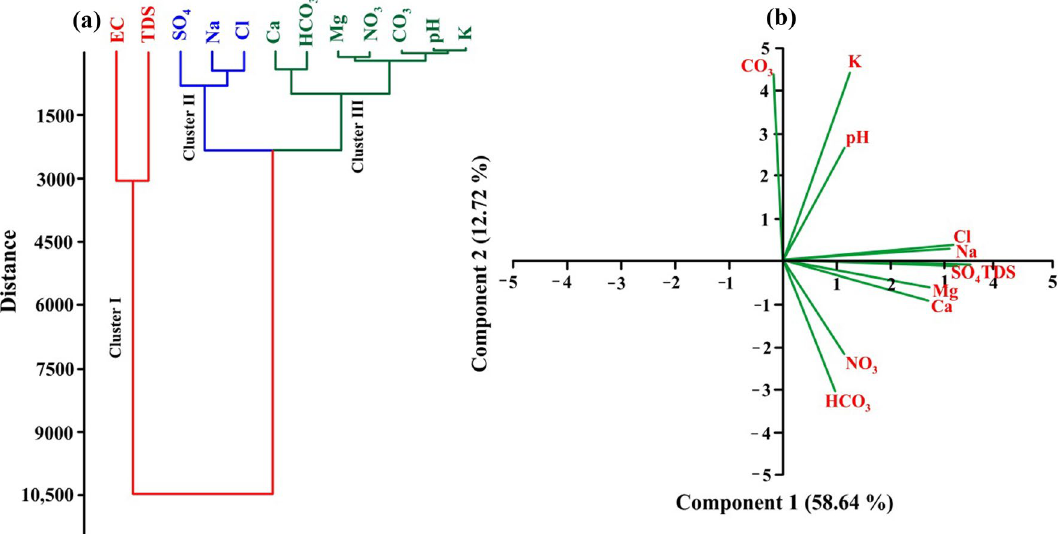
Fig. 11 The CA and PCA for physicochemical parameters of groundwater samples across Wadi Qanunah and Wadi Marawani basins: a CA and b